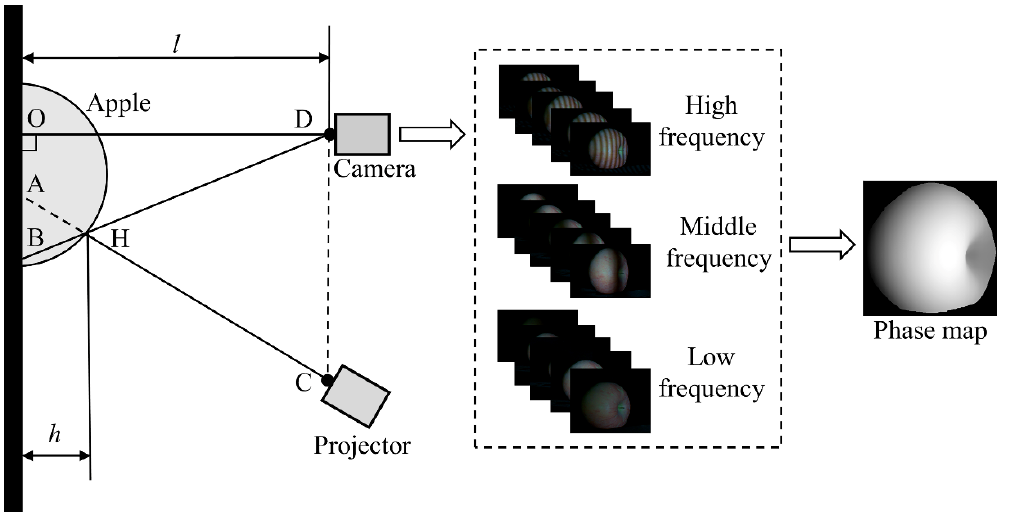
Figure 2. Schematic diagram of the system.